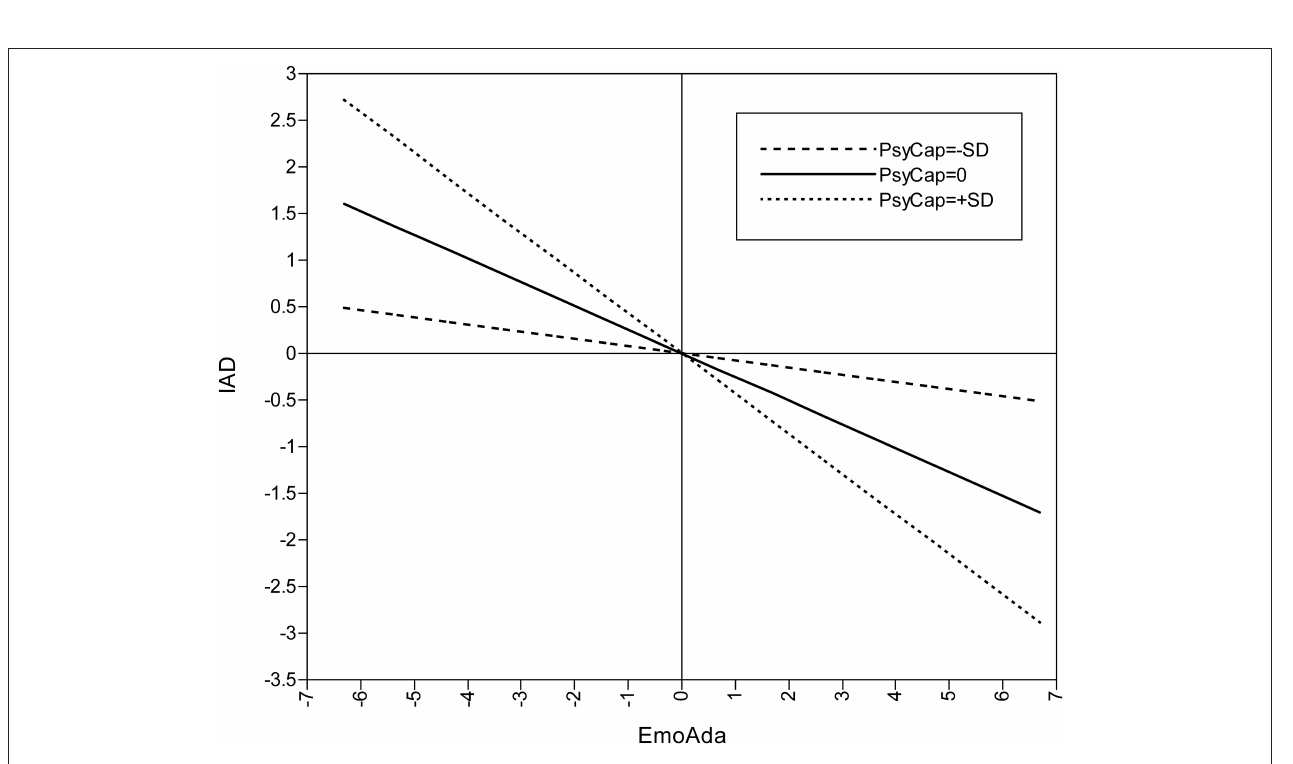
FIGURE 3 | Moderated effect of PsyCap on EmoAda and IA.